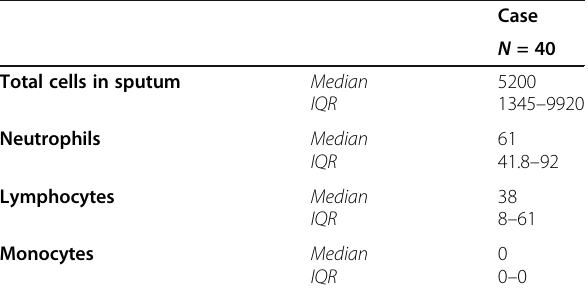
Table 5 Oxidative stress markers in studied groups Case